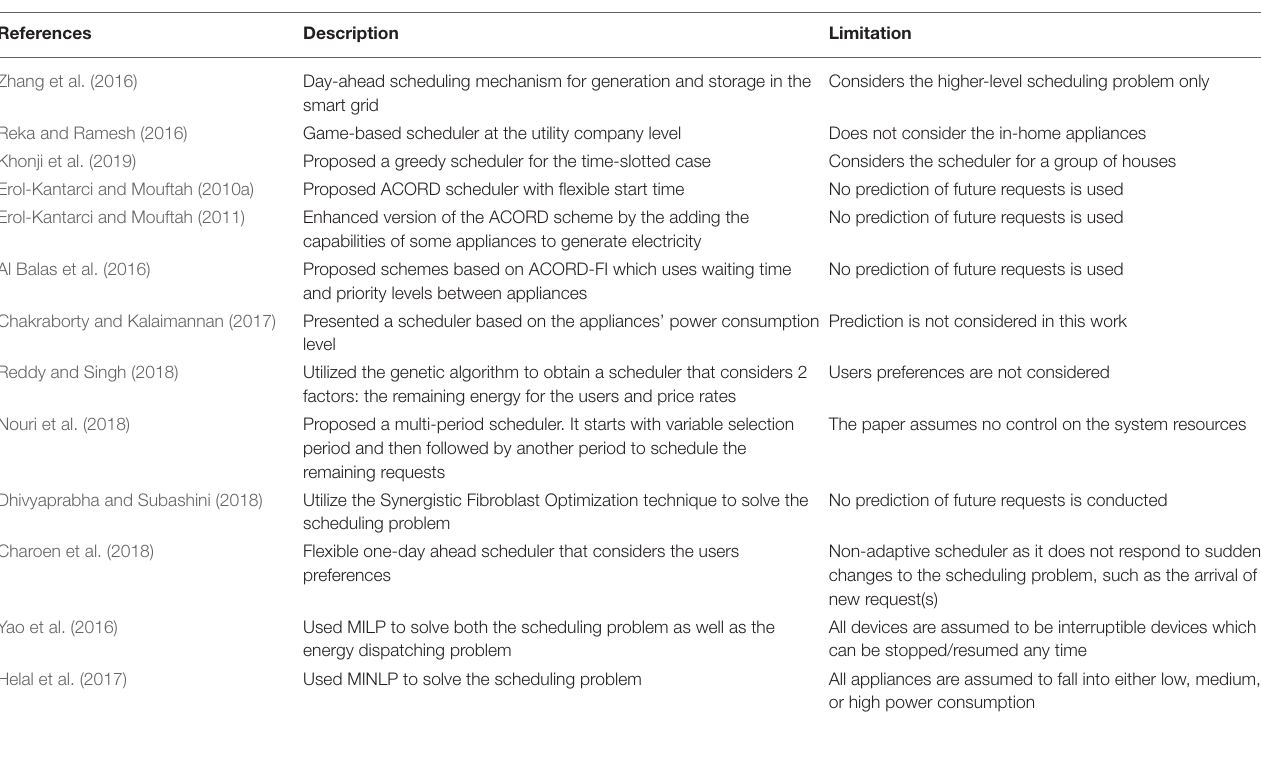
TABLE 2 | Literature review